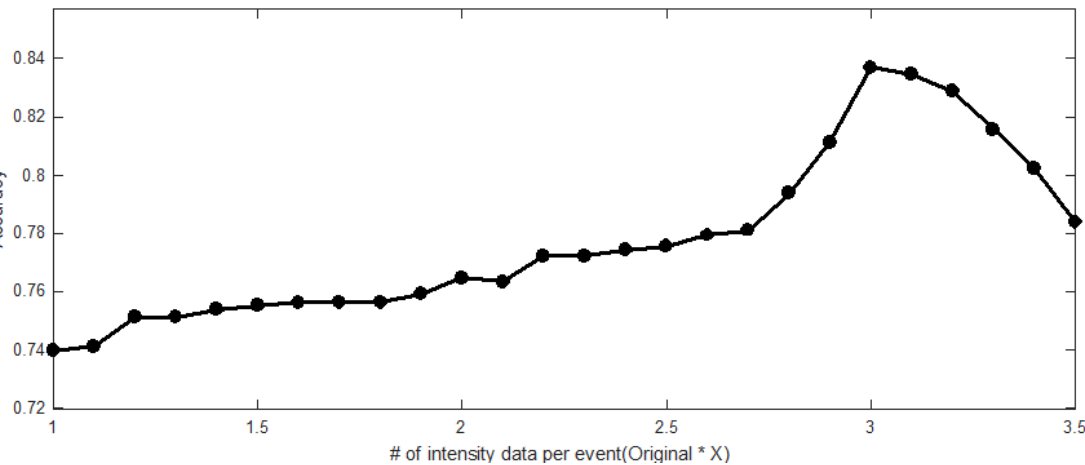
Figure 7. Each accuracy when increasing the data length through bicubic interpolation. The classification accuracy is improved if the length of the intensity data is increased compared to the original data. However, the classification accuracy is decreased if the increased length of the intensity data is exceeded three times compared to the length of the original data.